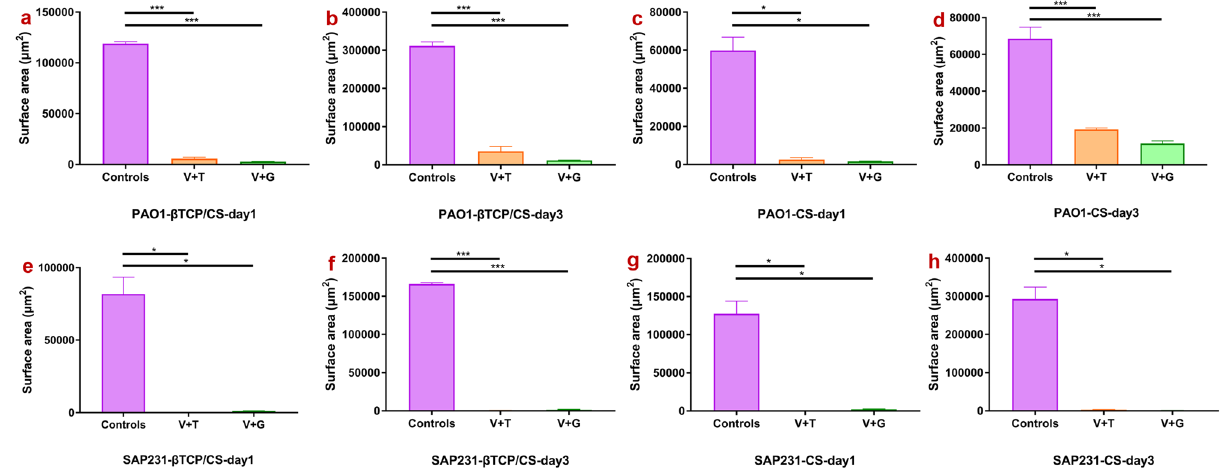
Figure 5. Surface area of P. aeruginosa PAO1 and S. aureus SAP231 biofilms in the prevention groups. The mean surface areas of PAO1 and SAP231 biofilms following V + T and V + G prophylaxic interventions at day 1 and day 3 were significantly lower than those of the respective controls. * P < 0.05, ** P < 0.01, *** P <